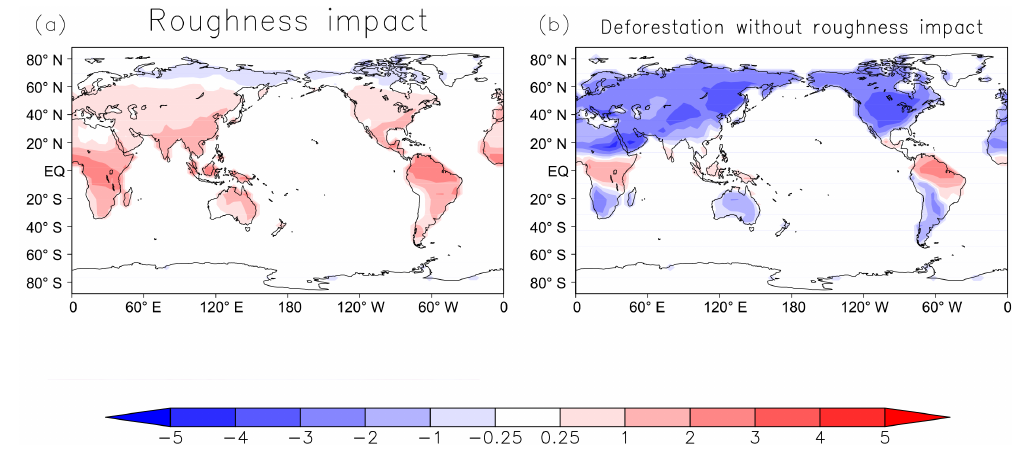
Figure 8. Panel (a) : impact of roughness (only) on temperature; panel (b) : temperature change without roughness (K). Table 4. Summary of the influence of individual biophysical factors on temperature change (K). Numbers in parentheses are changes in albedo and roughness. Albedo is unitless, and the unit for roughness is meters. Global Albedo Roughness Evapotranspiration efficiency